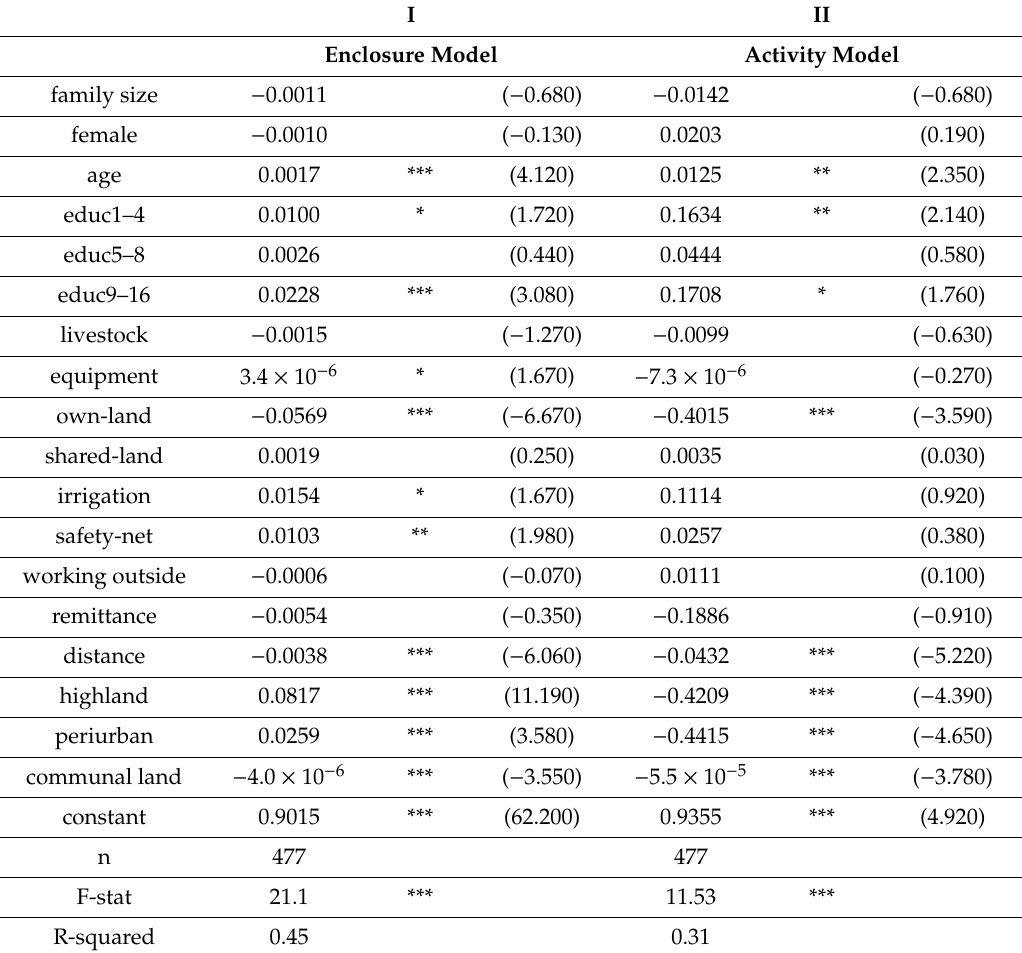
Table 4. Determinants of social